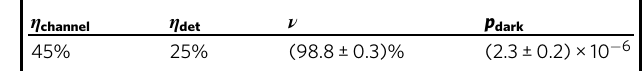
Table 1 Experimental parameters corresponding to our implementation and used in the